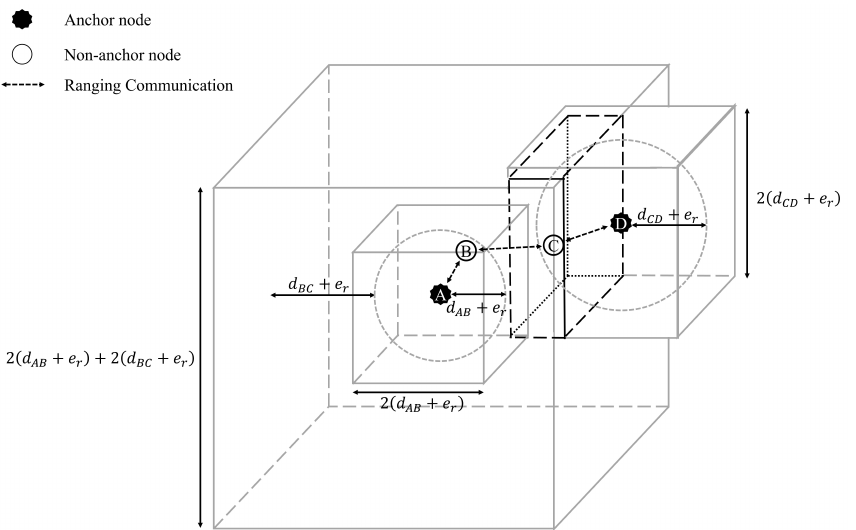
Figure 3. 3D bounding-box determination process. Node B initializes its B-box state vector b B after exchanging ranging message with node A . Node C initializes its B-box state vector b C after exchanging ranging message with node D . Finally, b C is updated after exchanging ranging message with B and is depicted as the bold dashed